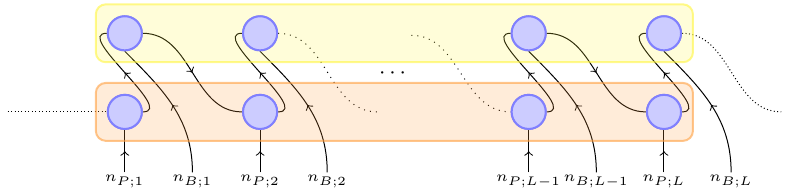
Figure 4: MPS representation in an enlarged Hilbert space with each physical site accompanied by a bath site.